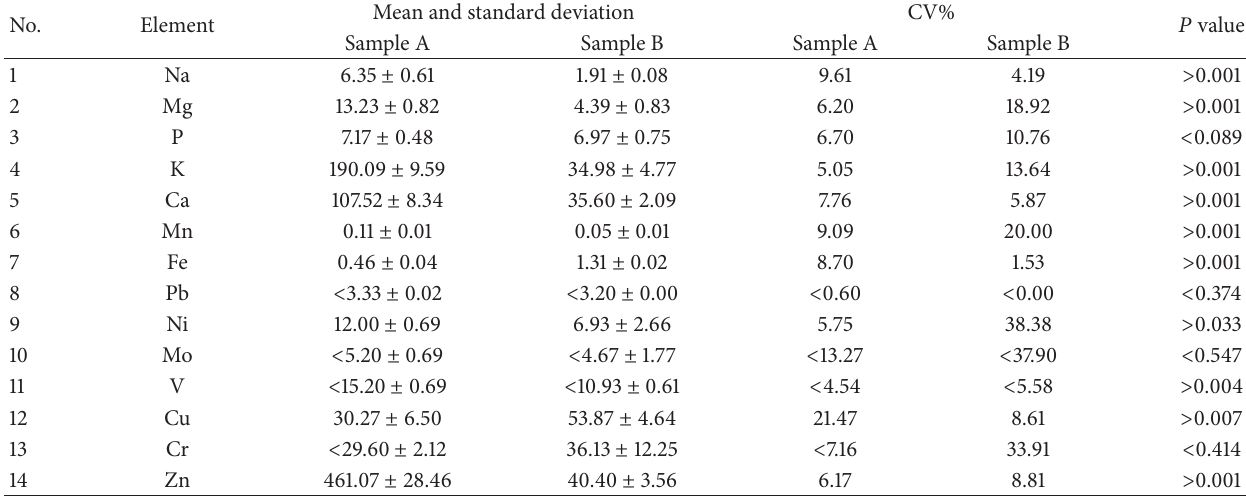
Table 1: Mean (mg/4g sample), standard deviation, coefficient of variance (CV%), and 𝑃 values for 14 selected elements.